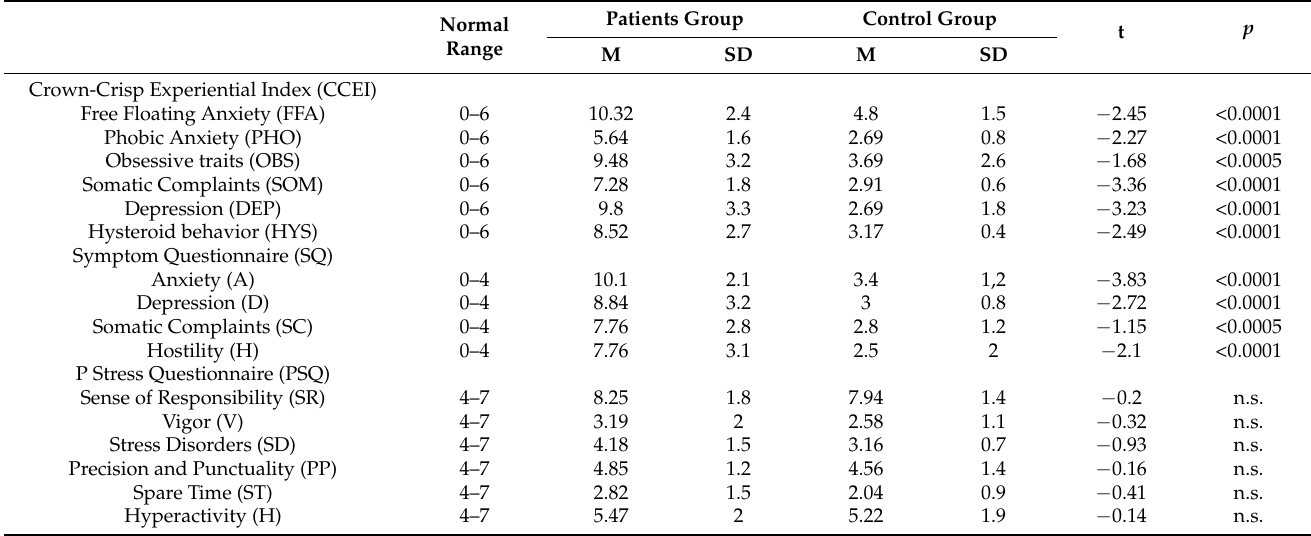
Table 2. Average values and comparisons of the psychometric tests between patients and